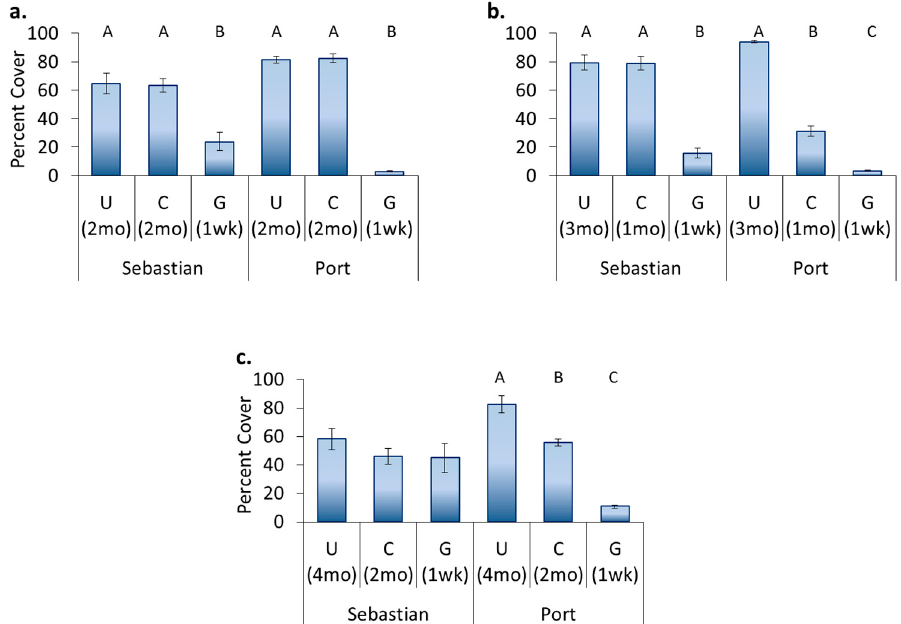
Figure 8. Differences in average, total macrofouling cover on DC3140 due to treatment. ( a ) In May, macrofouling cover was significantly lower on groomed than on uncleaned or cleaned panels at both locations ( p < 0.001). ( b ) In June in Sebastian, macrofouling cover on groomed panels was significantly lower than on uncleaned or cleaned panels ( p < 0.001). In Port Canaveral, uncleaned panels had the highest cover and groomed panels the lowest ( p < 0.001). ( c ) In July in Port Canaveral, cover was significantly higher on uncleaned and cleaned panels than groomed panels ( p < 0.001); cover on uncleaned panels was significantly higher than on cleaned panels ( p < 0.001). Error bars represent one standard error. The X-axis is treatment and the Y-axis is average percent cover. Treatments are uncleaned (U), cleaned (C) and groomed (G). The time in the parenthesis is elapsed time since treatment. Letters above the bars denote statistical significance (i.e., As are statistically similar to, but significantly different than, Bs).